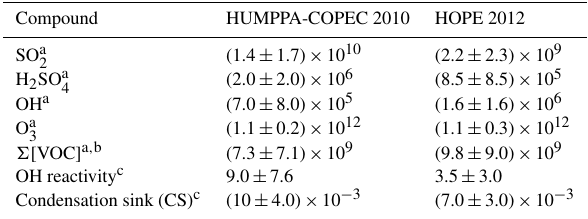
Table 1. Average concentration (moleculescm − 3 ) , with 1 σ vari- ability, of trace gases relevant for this